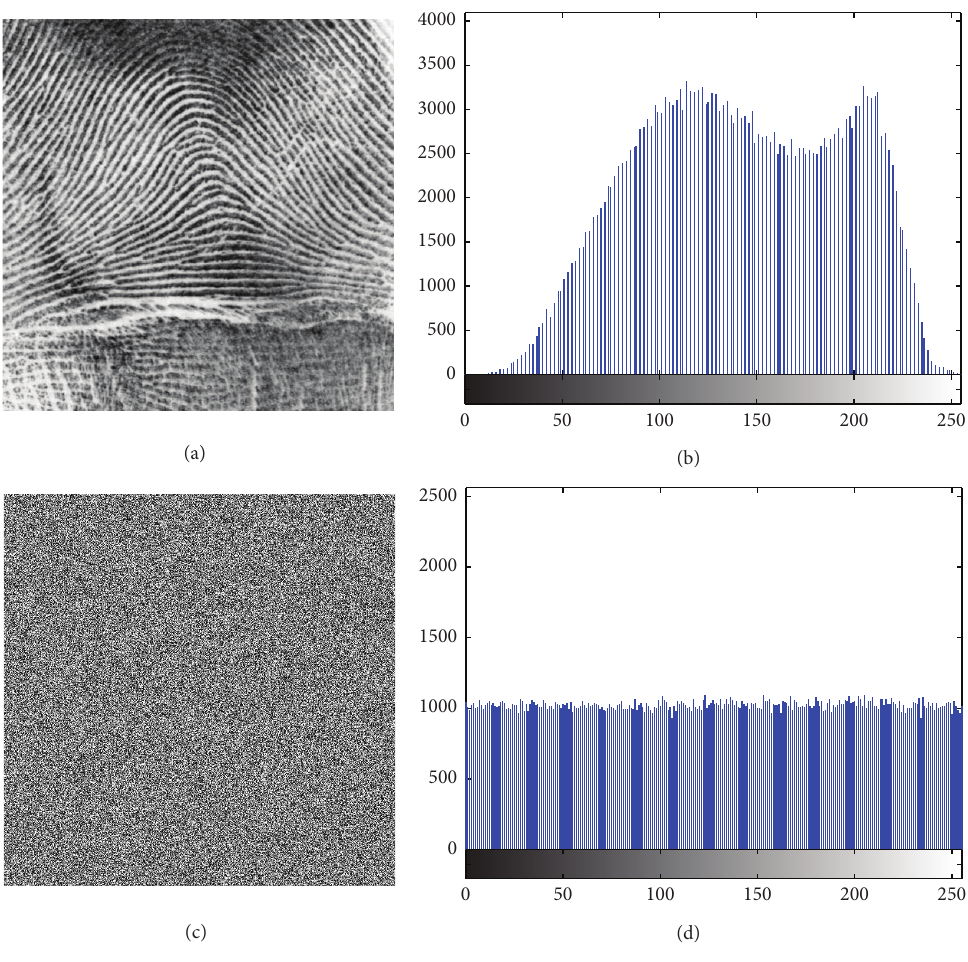
Figure 13: (a) Fingerprint image and (b) its histograms and (c) encrypted image and (d) its